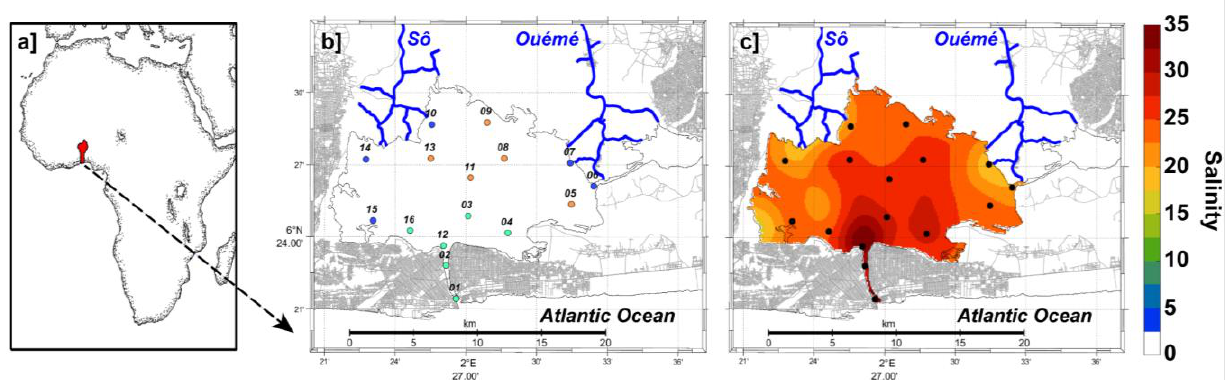
Figure 1. Location of Nokoué Lagoon (Benin) and hydrographic stations carried out between November 2019 and September 2020. ( a ) Benin location in West-Africa. ( b ) Mean salinity (SAL) during high water period in October (SAL ~ 0) and ( c ) during low water period in April (SAL ~ 25). Station numbers are shown in b]; green dots correspond to stations influenced by the Cotonou Canal and the Atlantic Ocean, blue dots by rivers, and red dots are intermediate stations more representative of the central zone of the lagoon.